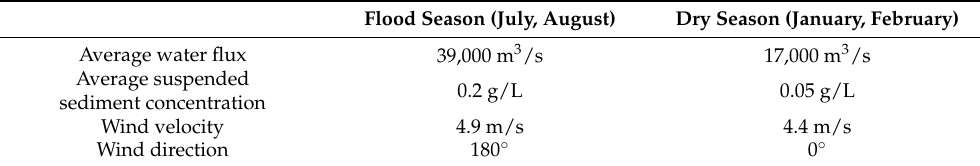
Table 2. Average values of water, sediment fluxes, and wind velocity in the Yangtze River during the flood and dry seasons in 2018.